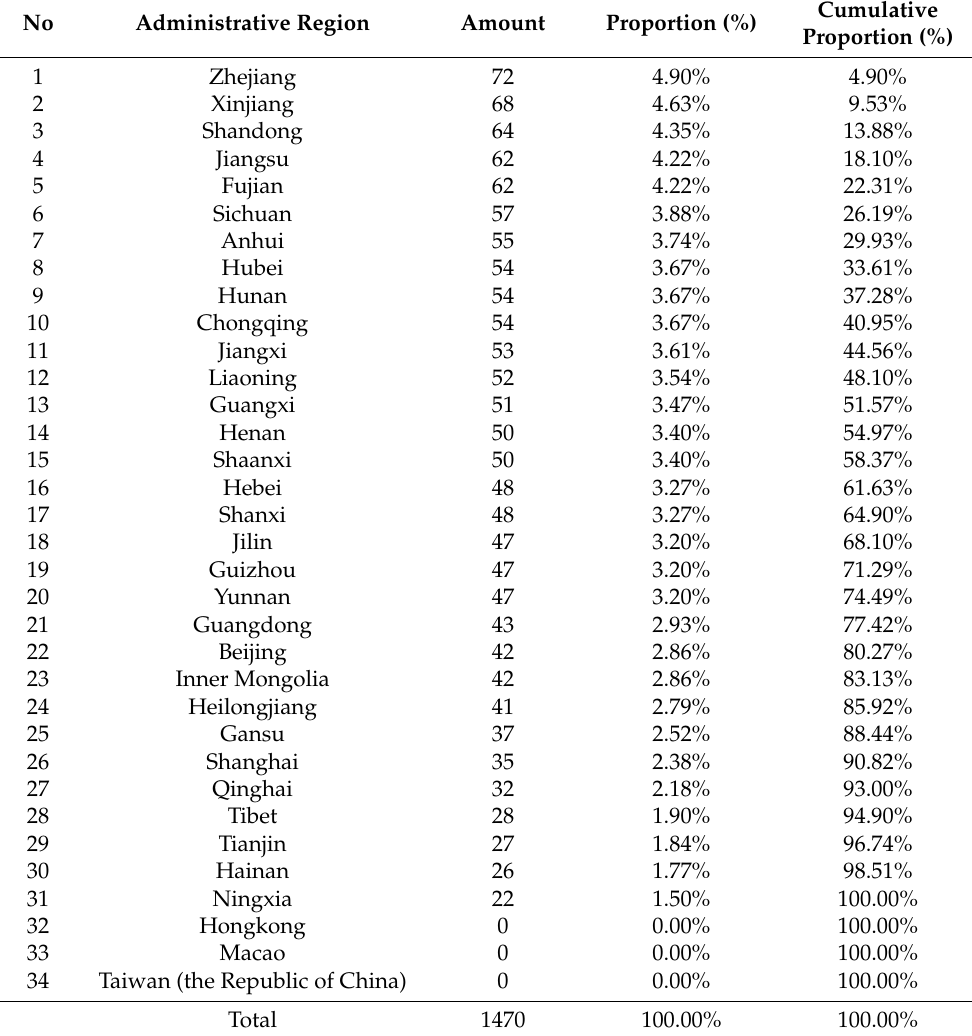
Table 1. Regional distribution statistics of beautiful leisure villages in